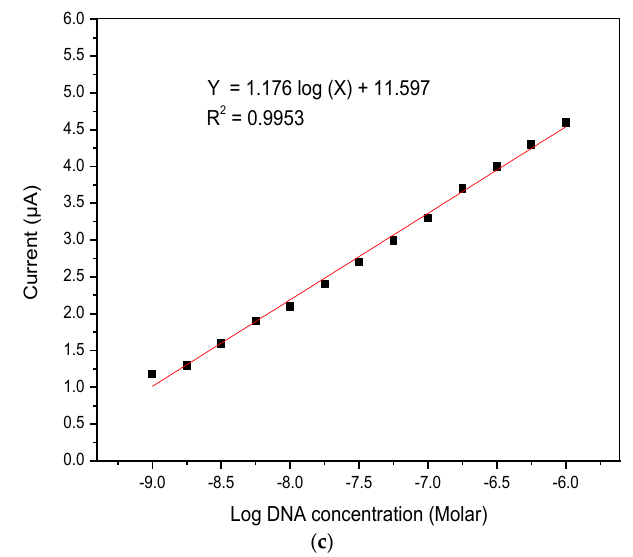
Figure 11 . ( a ) Histogram for DPV measurement of different concentration of DNA probe (1–15 µM); ( b ) DPV measurements of different concentration of DNA target (from a to m were 10 −6 M–10 −9 M) in phosphate buffer (0.1 M, pH 7) consisting MB (35 µM) at potential range (−0.2 V to +0.8 V); ( c ) plot of anodic peak current against log concentration of DNA target.